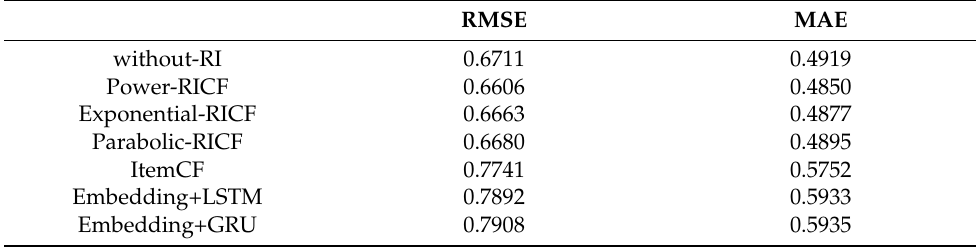
Table 5. RMSE of different comparative experiments on the DigitalMusic dataset.